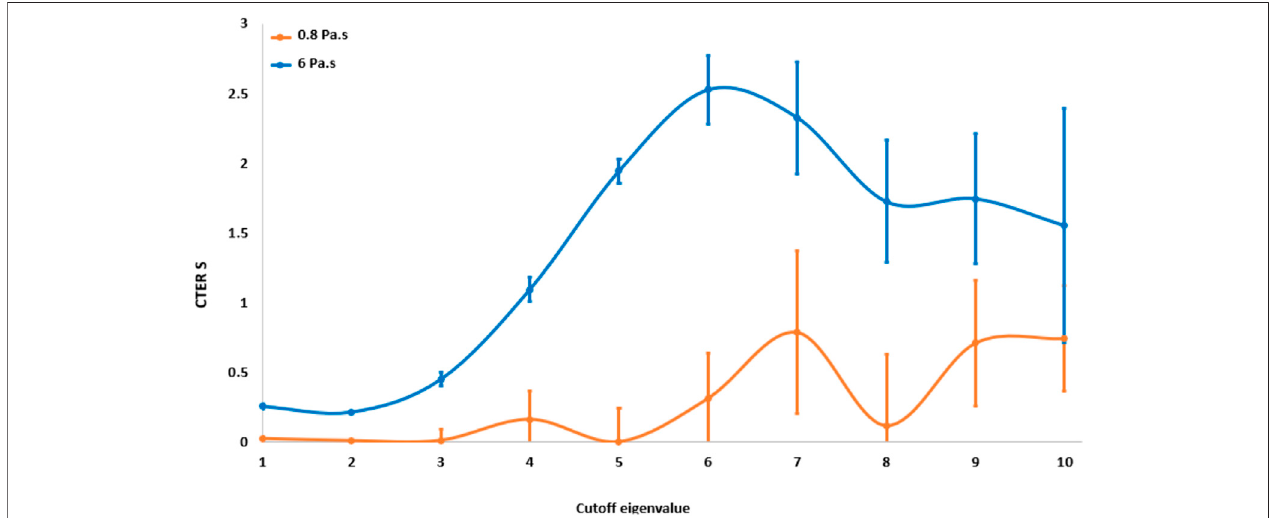
FIGURE 6 | CTER values of the S parameter as a function of the cutoff eigenvalue for the most viscous medium (6 Pa s) and the less viscous (0.8 Pa s).